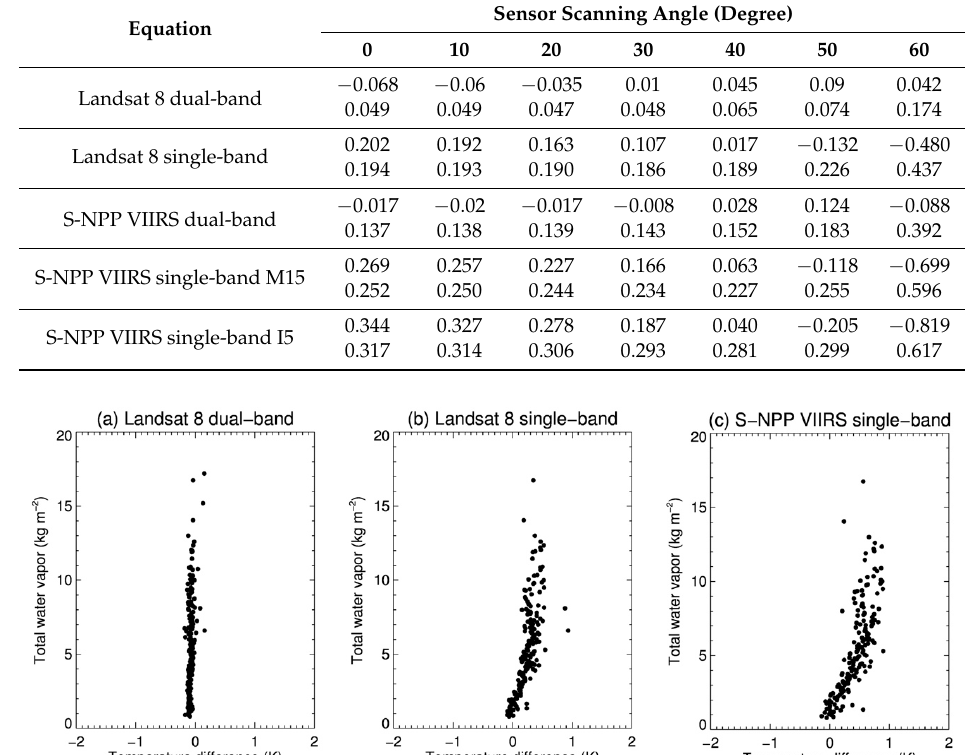
Table 3. Bias (top row in a cell) and standard deviation (bottom row in a cell) of the differences between dual-band and single-band ice surface temperature retrievals using Equations (1) and (2) and true ice surface temperatures for Landsat 8 and S-NPP VIIRS in the Arctic.